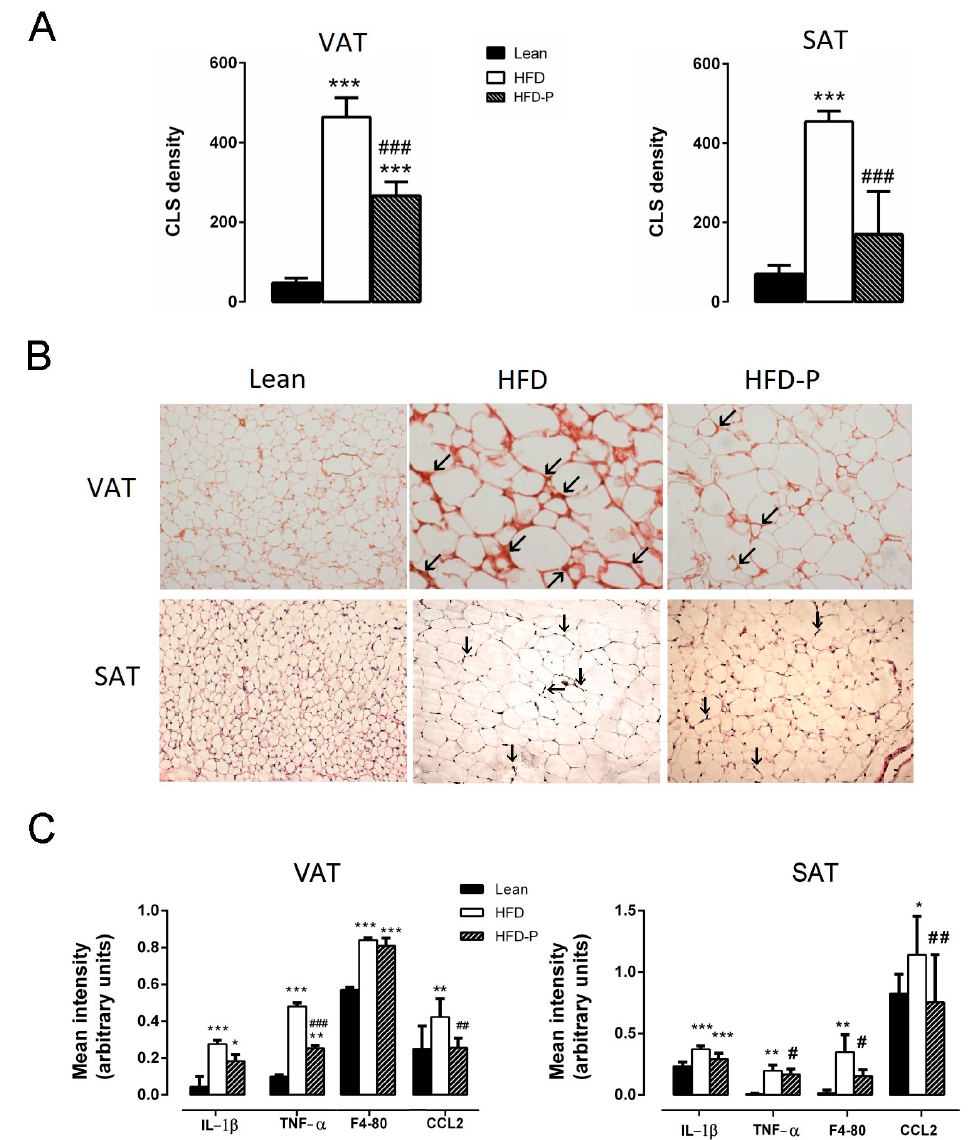
Figure 3. E ff ects of pistachio consumption on Crown Like Structures CLS density. ( A ) Representative results of the density of MAC-2 positive CLS stained in epididymal visceral adipose tissue (VAT) and subcutaneous adipose tissue (SAT) of the three groups of animals (CLS number / 10.000 adipocytes). ( B ) VAT and SAT immunohistochemistry (IHC) analysis for MAC-2 positive macrophages forming CLS (arrows) in the lean, HFD, and HFD-P animals (magnification 10 × ). ( C ) E ff ect of Pistachio consumption on IL-1 β , TNF- α , F4-80, and CCL2 mRNA expression in VAT and SAT of the lean, HFD, and HFD-P mice. Data are expressed as mean ± SEM; ( n = 8 / group). * p < 0.05 compared to the lean mice (* p < 0.05; ** p < 0.01; *** p < 0.001); # p < 0.05 compared to the HFD mice (# p < 0.05; ## p < 0.01; ### p <